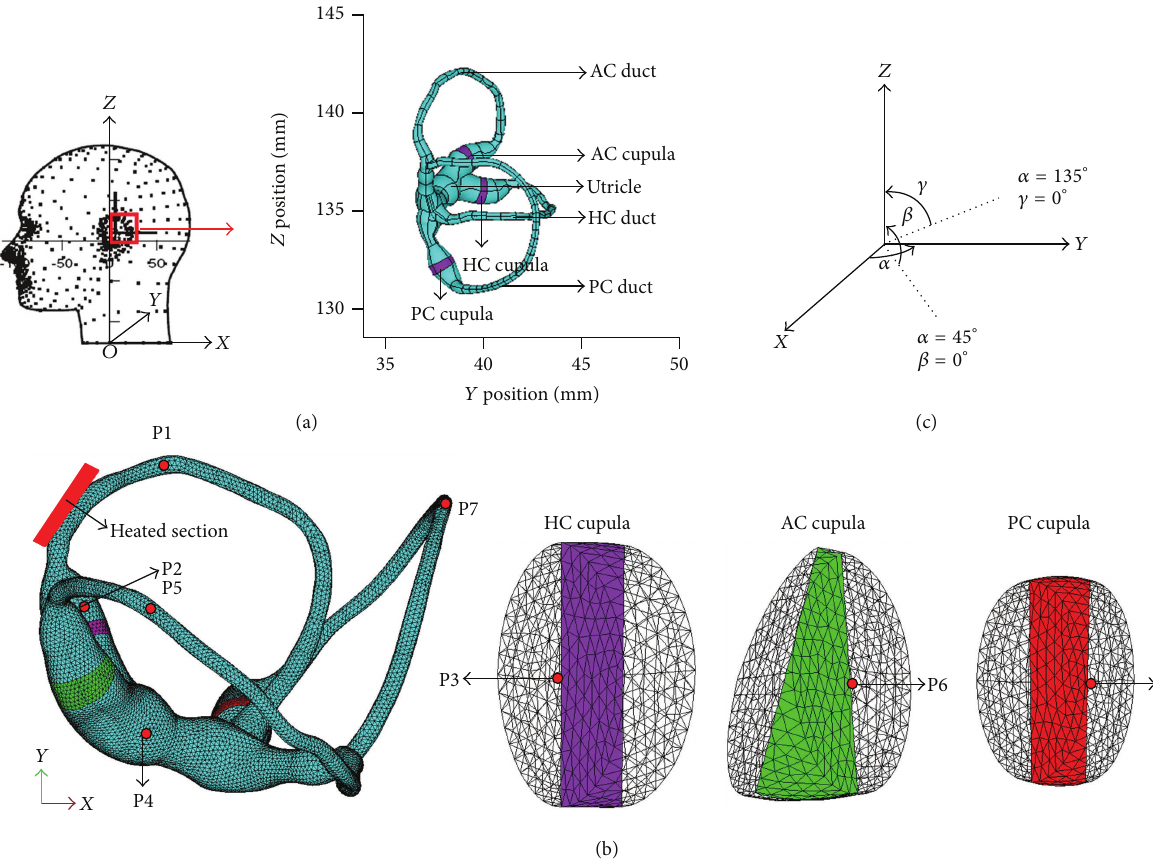
Figure 1: (a) The reconstructed model of a healthy human membranous labyrinth with dimension extracted from the report by Ifediba et al. [18]. The reconstruction is presented with + 𝑋 as posterior, + 𝑌 as right lateral, and + 𝑍 as superior. (b) Finite element mesh used for the simulations.(c)Thegravitationaldirectionduringthecalorictest.Thegravityisparalleltothe+ 𝑋